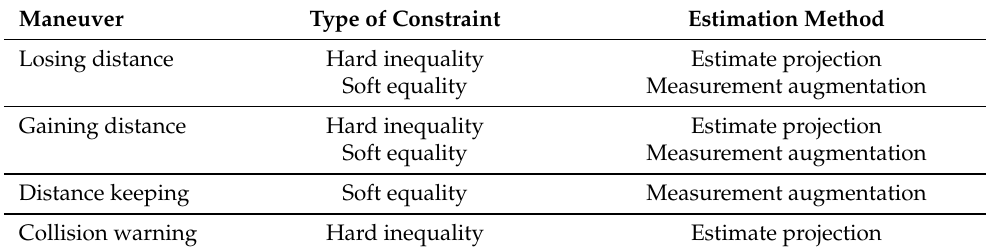
Table 6. Constraint type of longitudinal maneuvers.